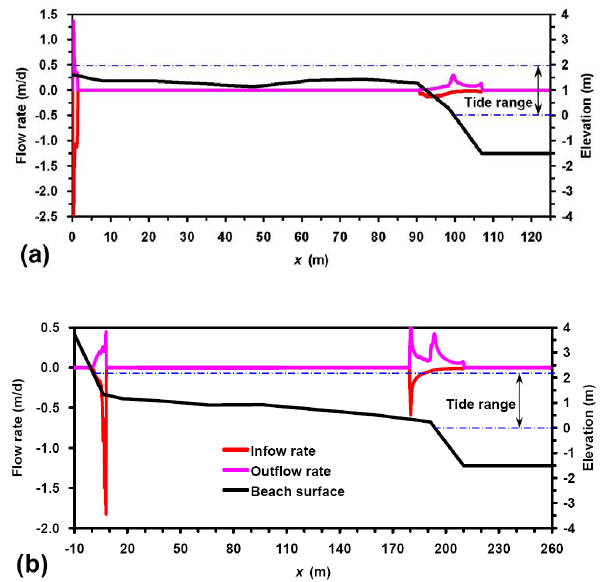
Fig. 12. Average flow rates extracted from the numerical simula- tions over the observation period of 3 days along (a) the mangrove and (b) the bald beach transects. Beach surface and tide range are shown to indicate the distributions of flow rate with them. Note the different scales used for each transect.